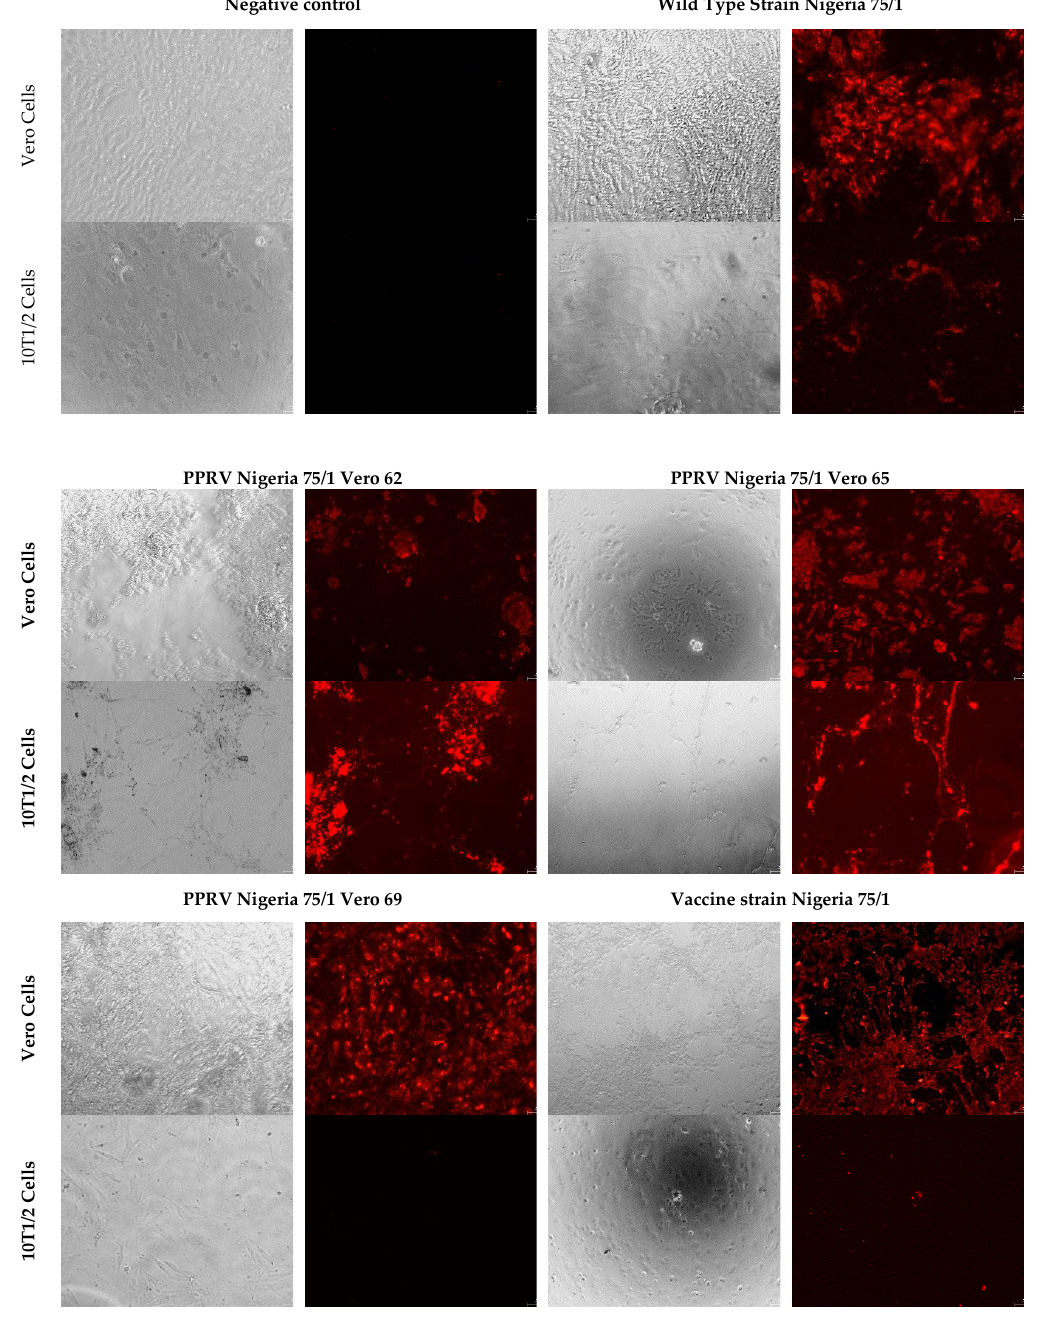
Figure 4. Infection of 10 T1/2 cells with different cellular passages leading to the attenuation of the vaccine strain Nigeria 75/1.